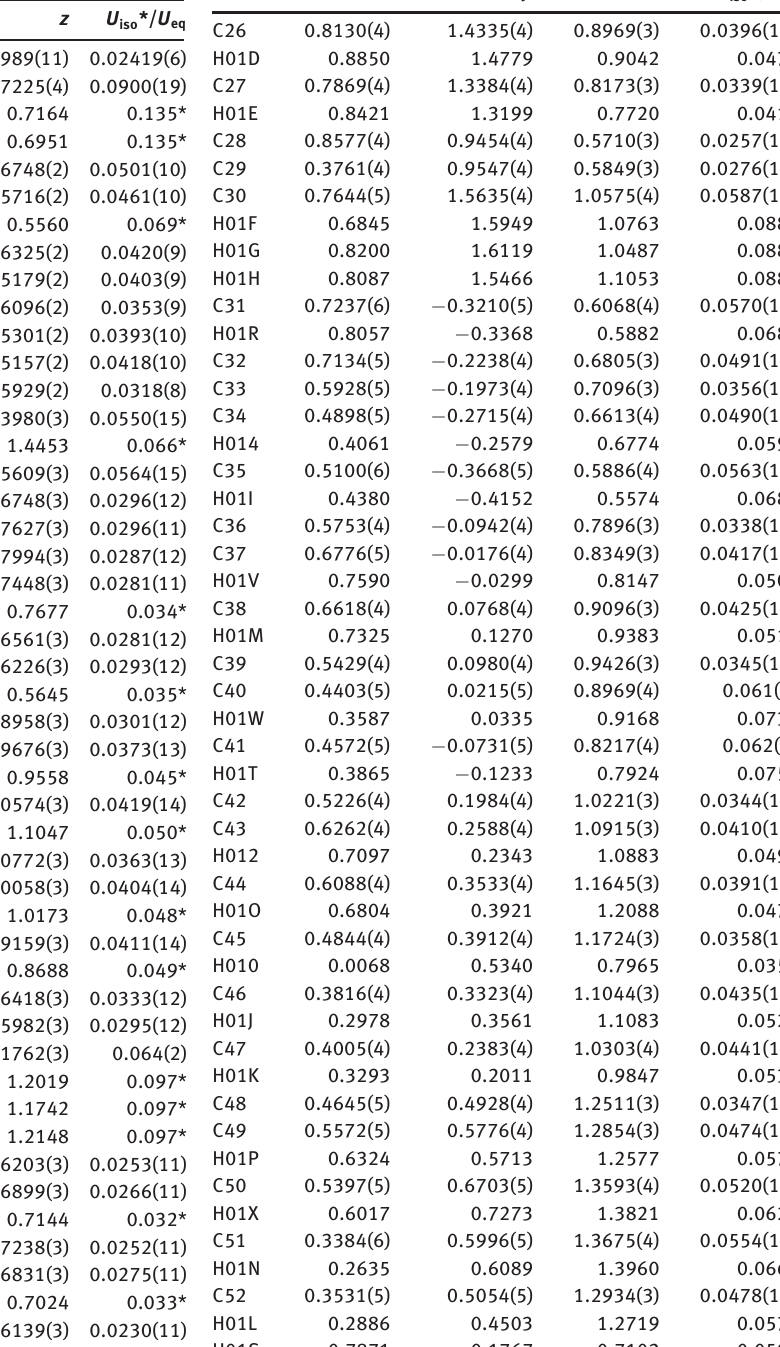
Table 2: Fractional atomic coordinates and isotropic or equivalent isotropic displacement parameters (Å 2